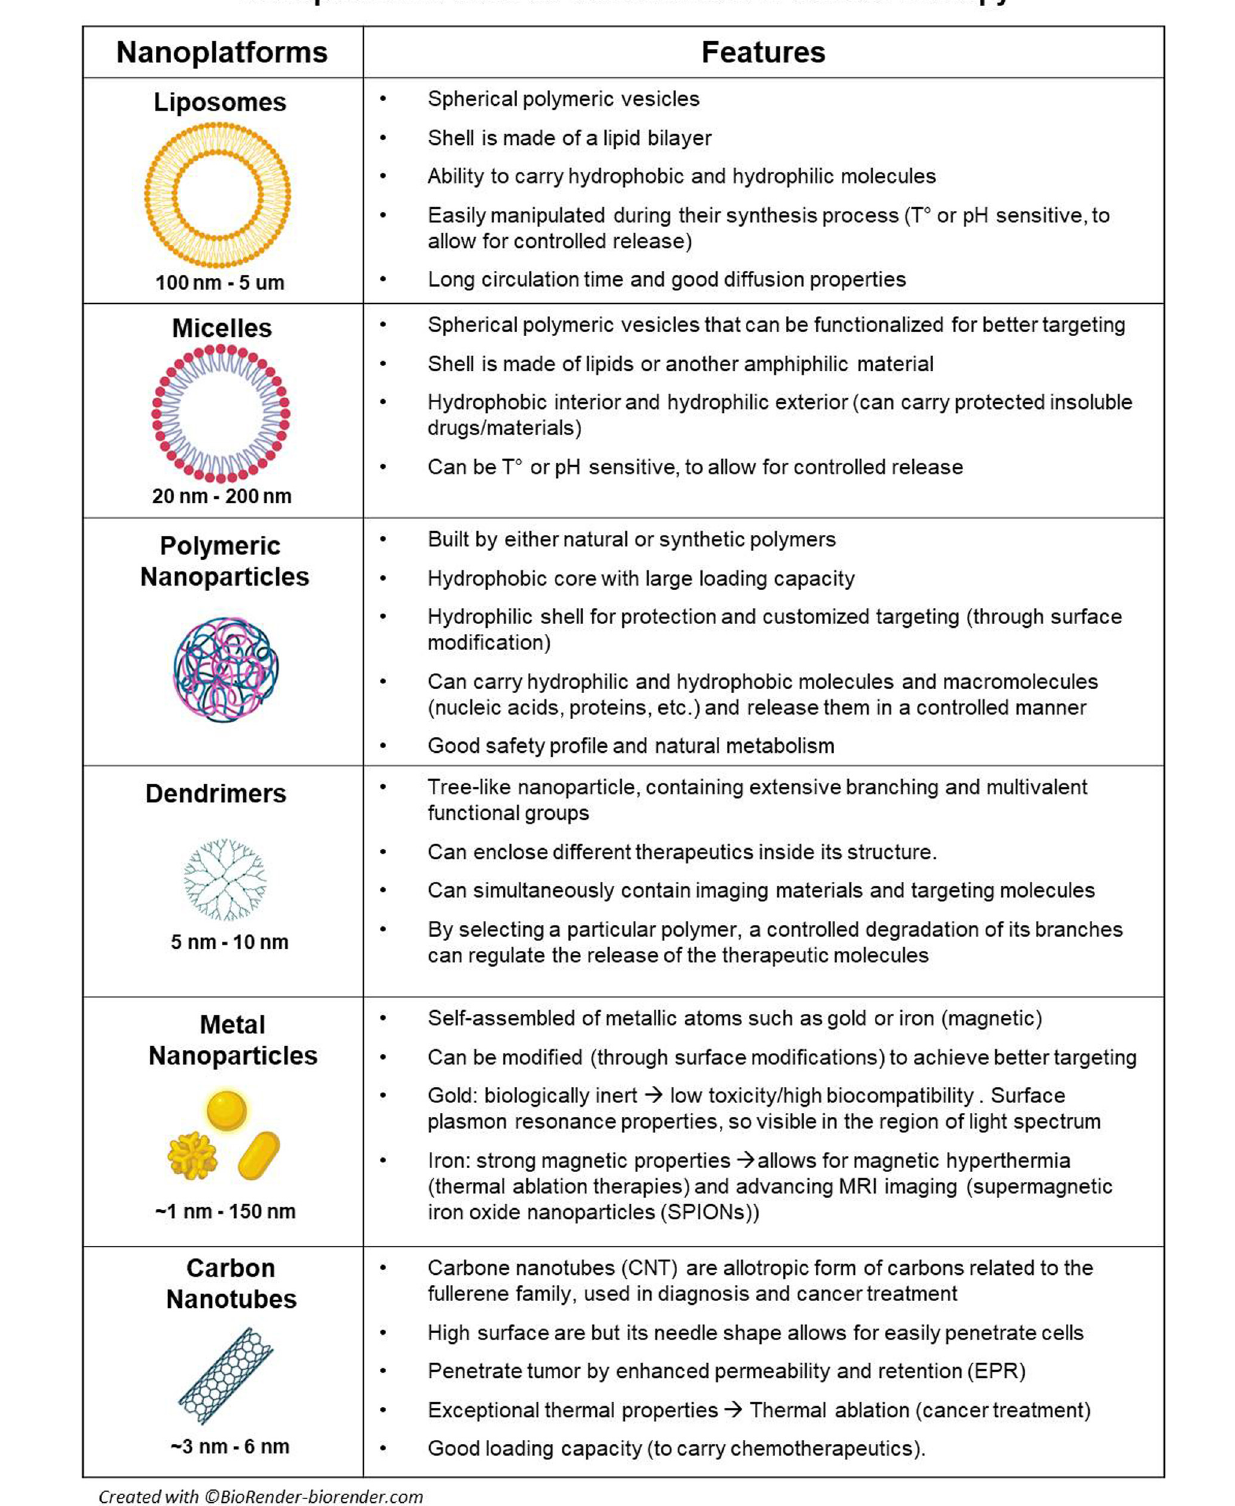
Frontiers in Bioengineering and Biotechnology |